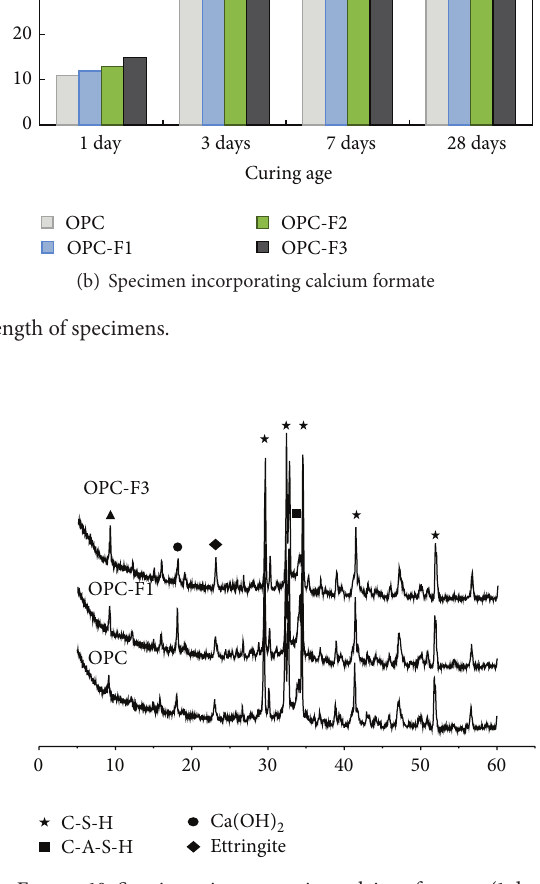
Figure 10: Specimen incorporating calcium formate (1